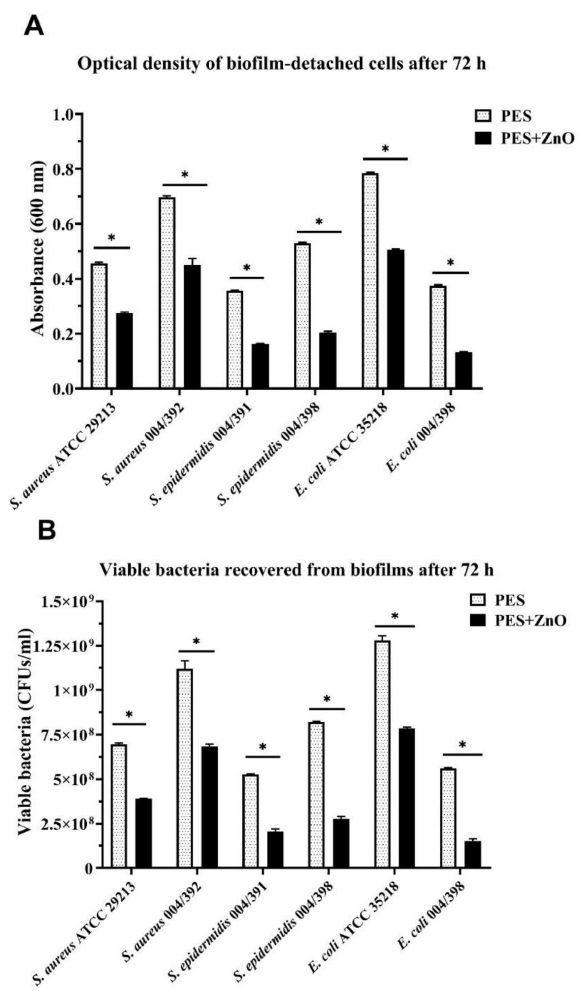
Figure 7. E ff ect of ZnO addition to PES on biofilm formation. Bacterial strains were grown on PES both in absence or presence of zinc oxide for 72 h. The histograms represent the OD 600 values of biofilm detached cells ( A ) and viable bacteria (CFUs / mL) recovered from biofilms ( B ) for each bacterial strain, in the two experimental conditions. The bars represent the means ± SD of three independent experiments performed in triplicate (S.D. = standard deviation). Statistically significant di ff erences, determined by two-way analysis of variance ANOVA, are indicated by * p < 0.0001 PES / ZnO vs. PES.